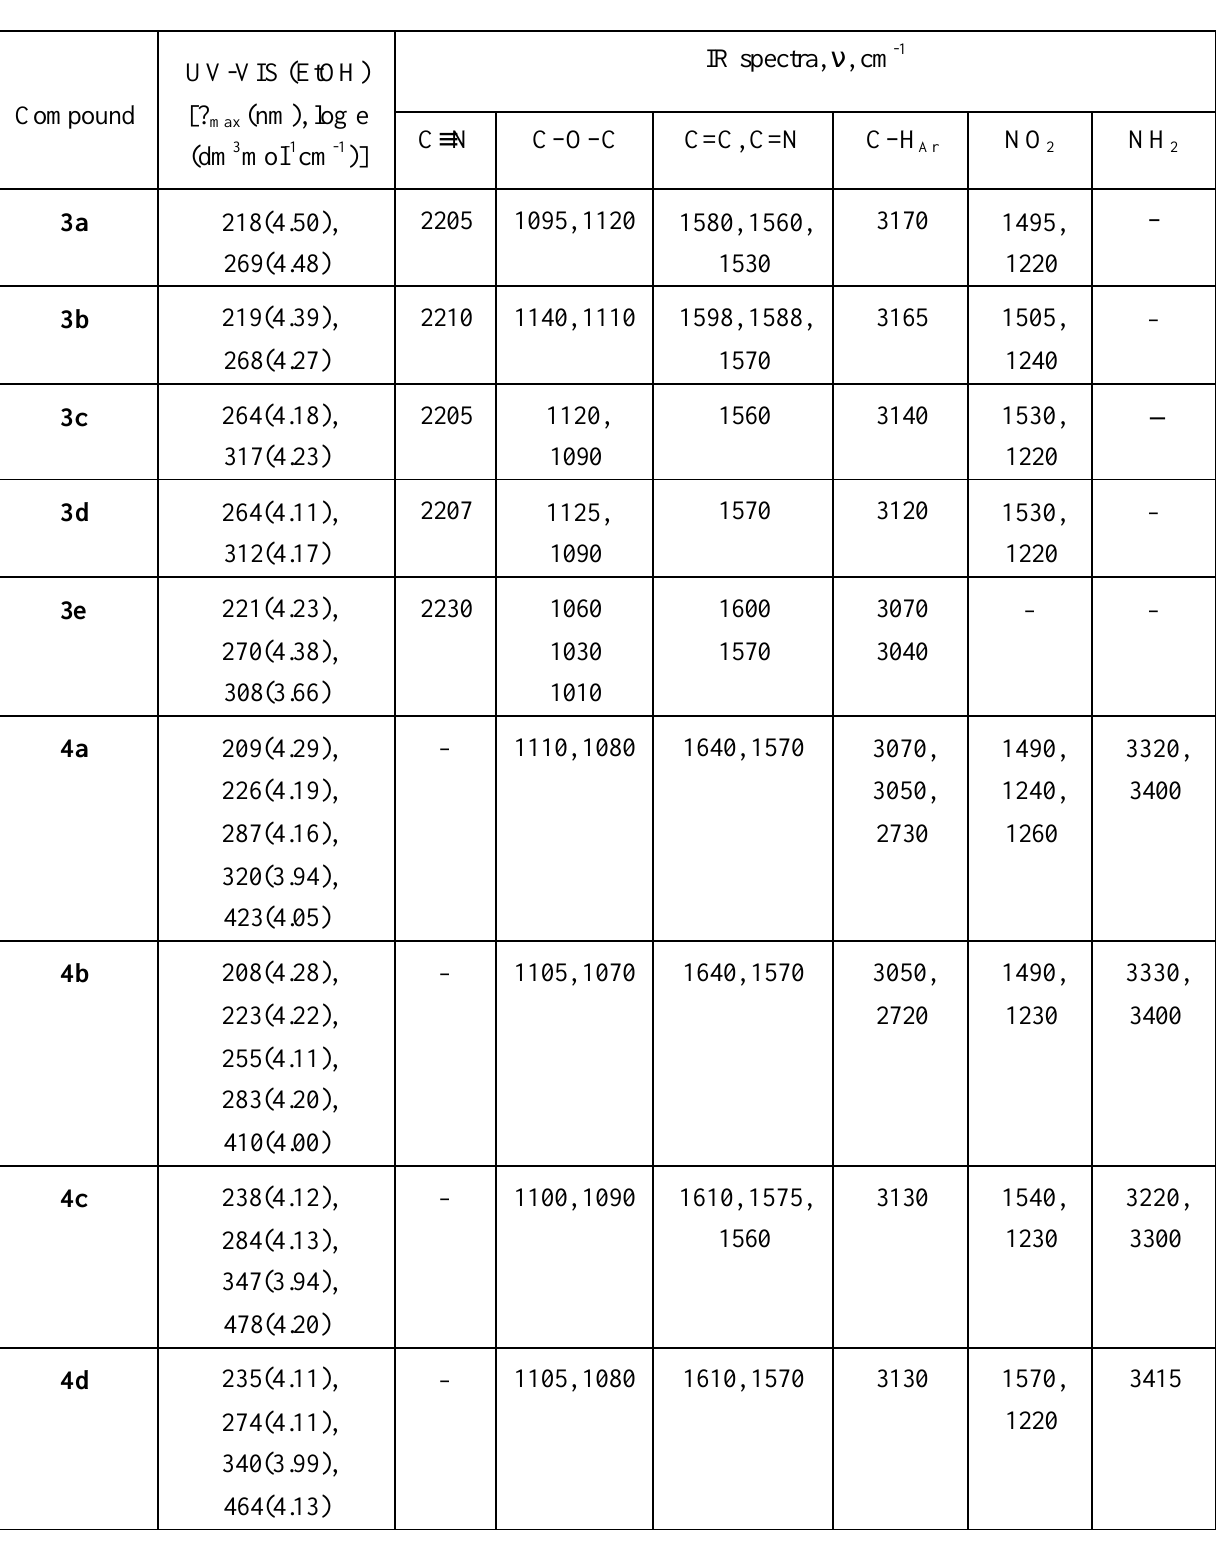
Table 2 – IR and UV-VIS spectra of synthesised compounds